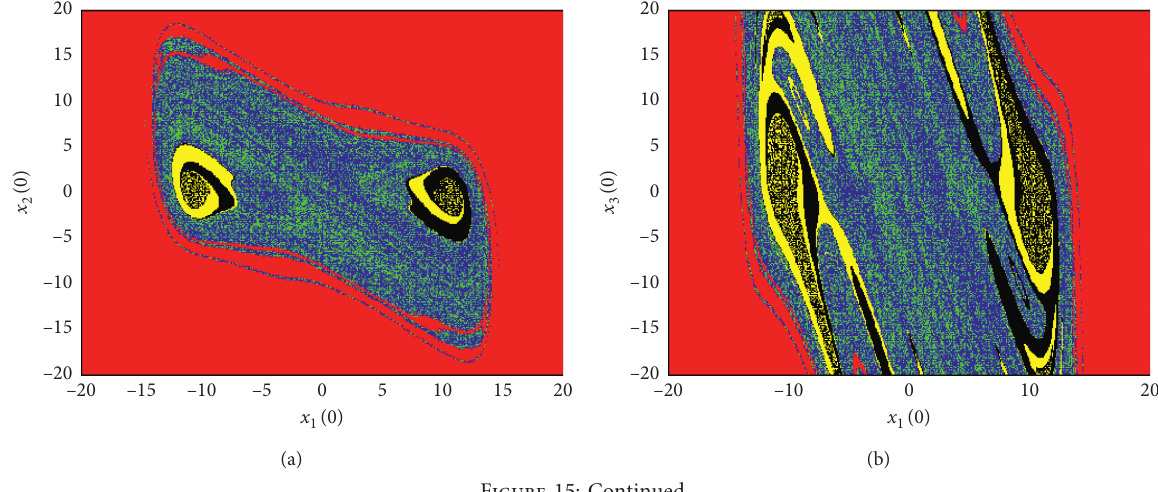
Figure 14: (a, b) Coexistence of four distinct attractors (a pair of chaotic attractors represented in x fixed point attractor) and their corresponding basin of attraction. Initial conditions ( x respectively, ( ± 7 . 15 , 0 , ± 8 . 613 , 0 ) and ( ± 12 . 8 , 0 , 0 , 0 ) . The rest of the parameters are a � 1 . 8, b � 3 . 5, c � 2 . 442, d � 1 . 35, e � 15, and m �